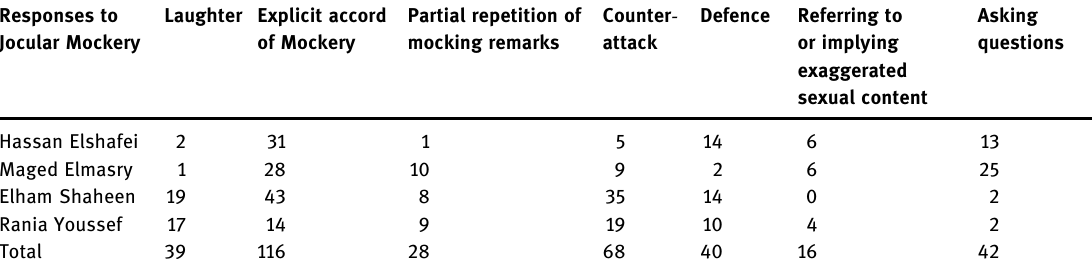
Table 4: Classi fi cation and frequencies of recipients ’ responses Responses to Jocular